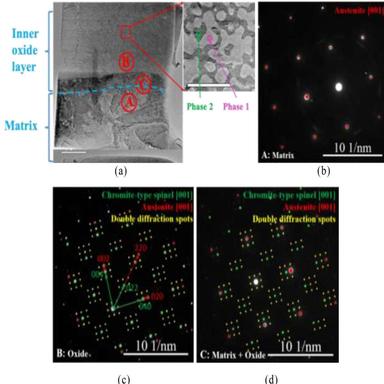
(a) BFTEM image showing the TEM sample 1 prepared at the inner oxide layer-metal matrix interface and high-resolution BFTEM image showing that the inner oxide layer consists of two phases; (b) SAED pattern taken at Region A in (a) showing an austenite phase of the metal matrix; (c) SAED pattern taken at Region B in (a) showing the existence of double diffraction in the inner oxide layer; (d) SAED pattern taken at Region C in (a) showing that the SAED pattern obtained from the metal matrix is coherent with t